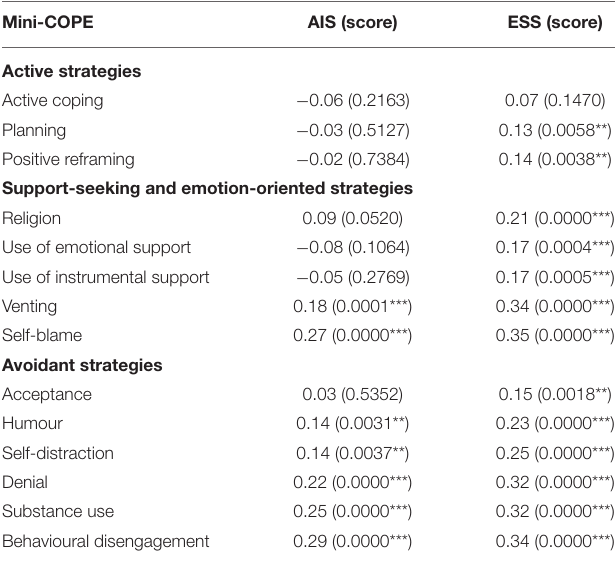
TABLE 2 | Correlations between coping responses and measures of sleep problems ( N = 448).